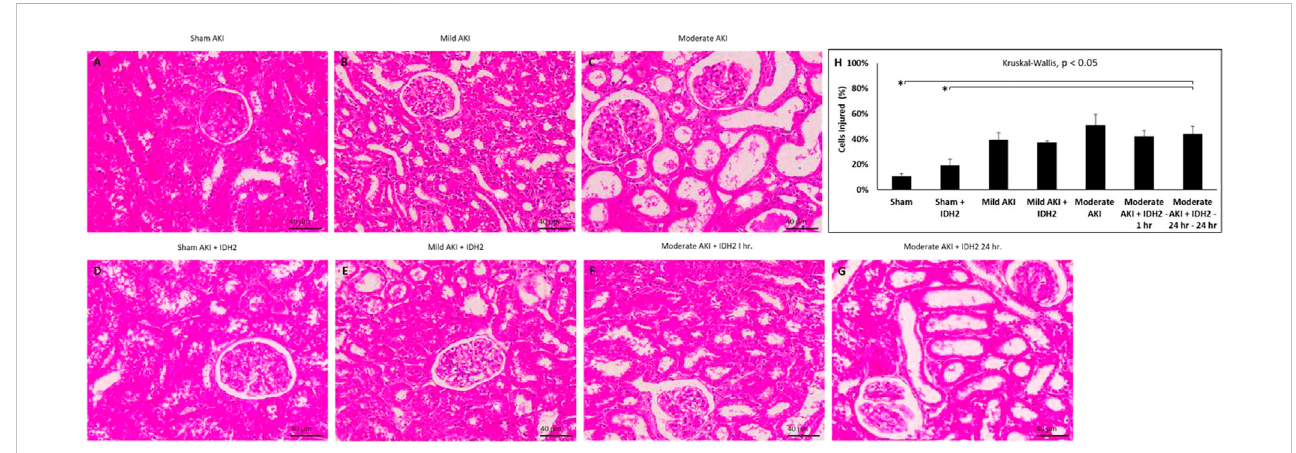
FIGURE 7 Histological assessments. X60 bright fi eld images of cortical sectionsfrom (A) sham AKI, (B) mild AKI, (C) moderate AKI, (D) Sham AKI + IDH2, (E) mild AKI + IDH2 (HD1-h post-reperfusion), (F) moderate AKI+ IDH2 (HD 1-hpost-reperfusion) (G) moderate AKI+ IDH2 (HD24-h post-reperfusion). (H) Comparison oftheinjurylevelsobservedintubularcellsfromalltheabovegroups. n =3forallgroups.Scalebar,40 μ m*representssigni fi cantdifferencesbetweengroups at a level of p <